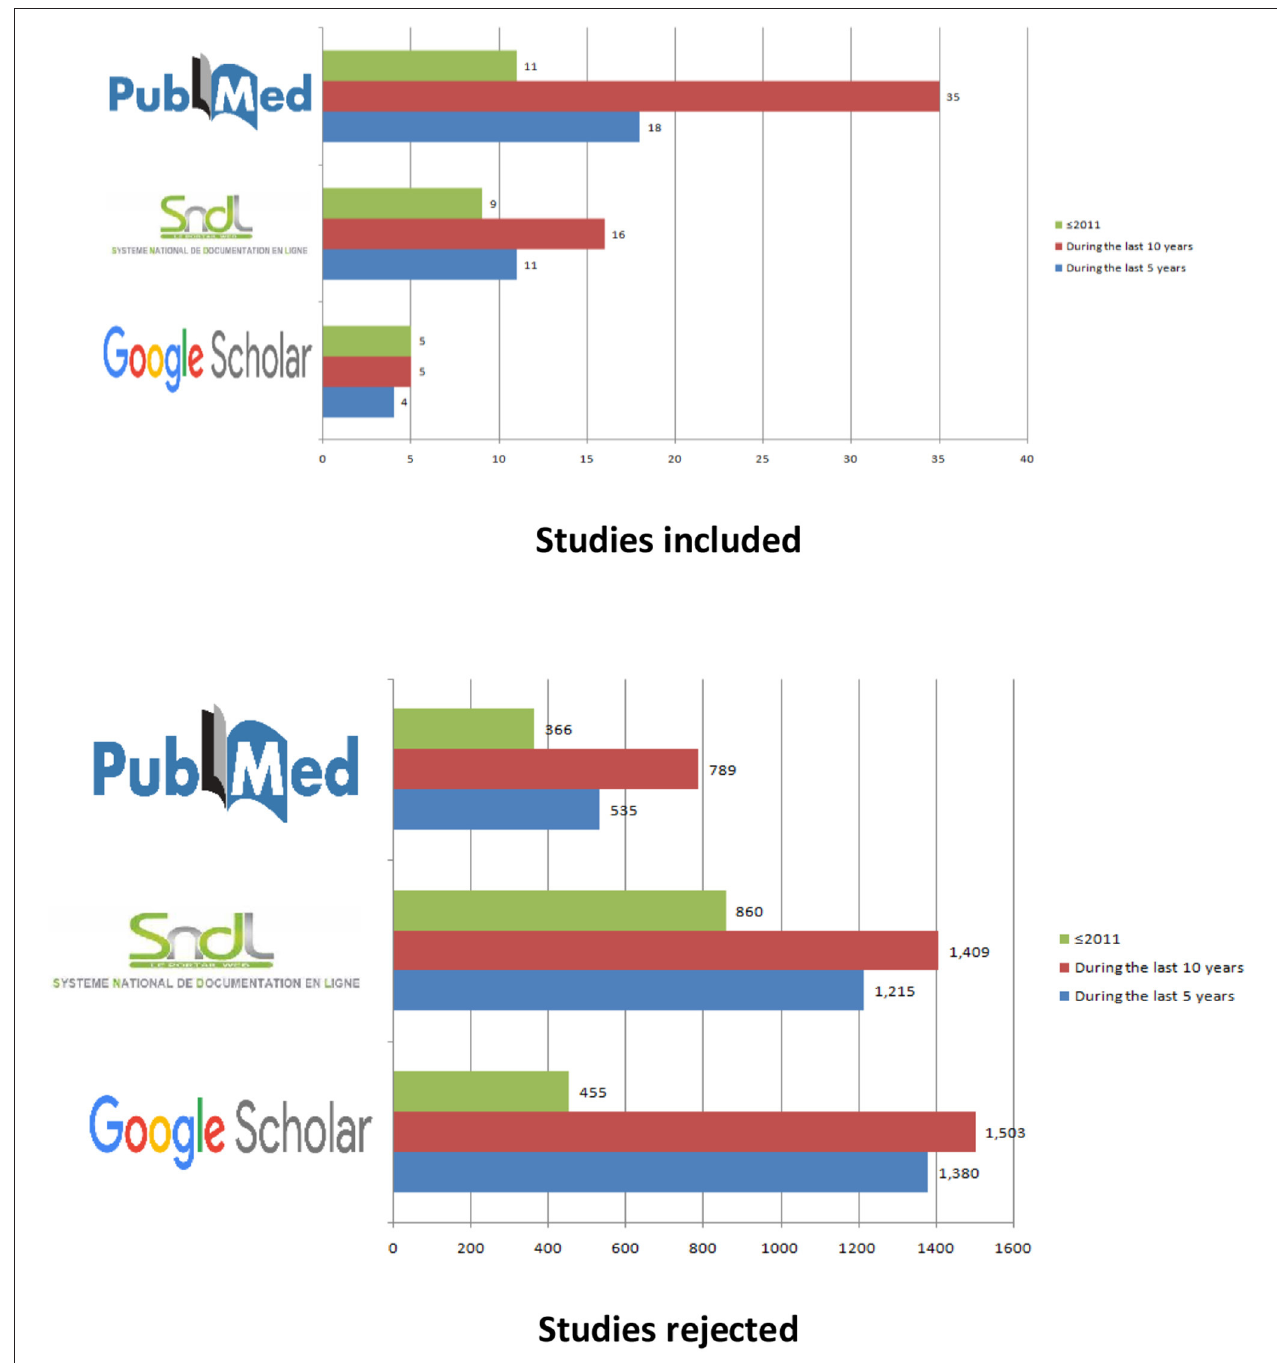
FIGURE 1 | Studies included and rejected according to the literature search.